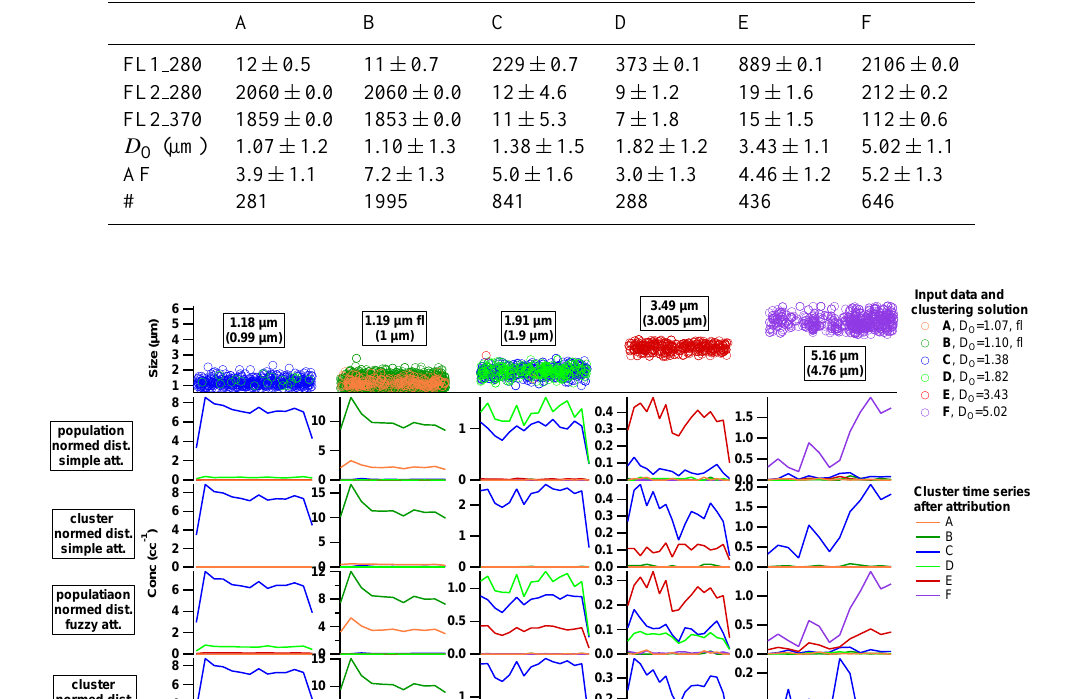
Table 3. Cluster average values and relative standard deviations of the six major clusters of the 13-cluster solution. Bottom row shows the number of constituent measurements. Minor clusters have been disregarded.